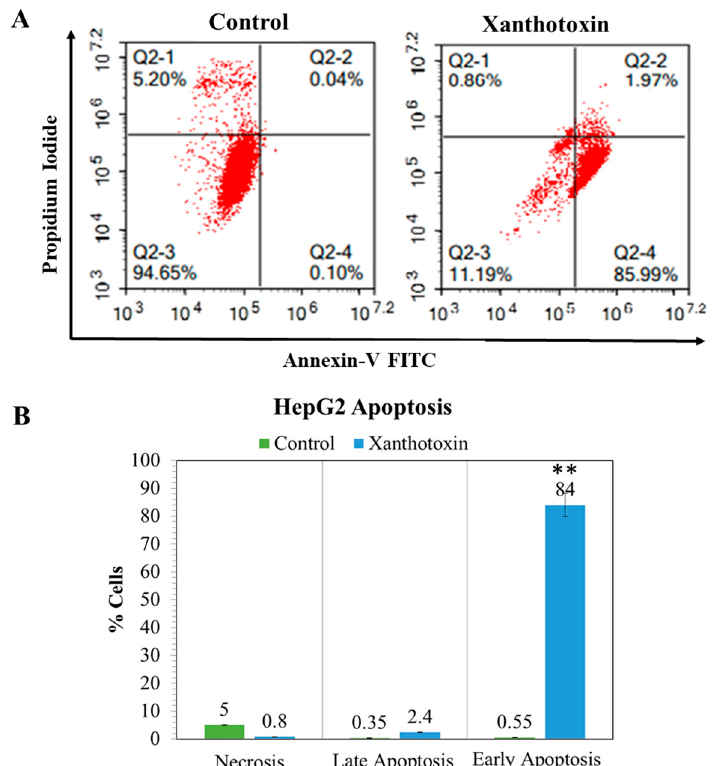
Figure 5. A graphical representation of the programmed cell death of the HepG2 cells after treatment with xanthotoxin. ( A ) Flow cytometric histograms representing the annexin-V/PI staining of HepG2 seeded at 2 × 10 3 cells for 48 h in complete DMEM and treated with 6.9 µ g/mL of xanthotoxin compared with control cells. ( B ) Diagrams of the percentage of necrosis and apoptosis for xanthotoxin in comparison with control cells. All analyses were carried out in triplicates, and values are expressed as means ± SEM. ** denotes significant difference at p < 0.01.